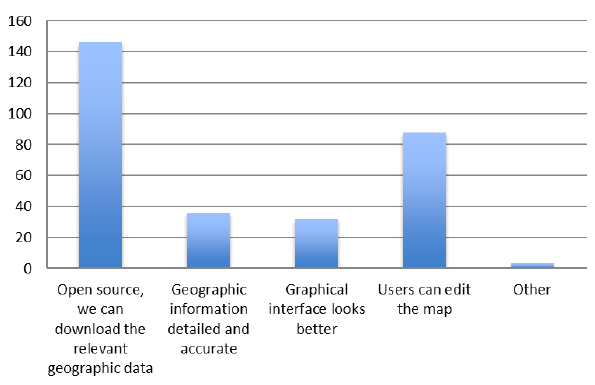
Figure 7. The advantages of OSM compared with other web maps